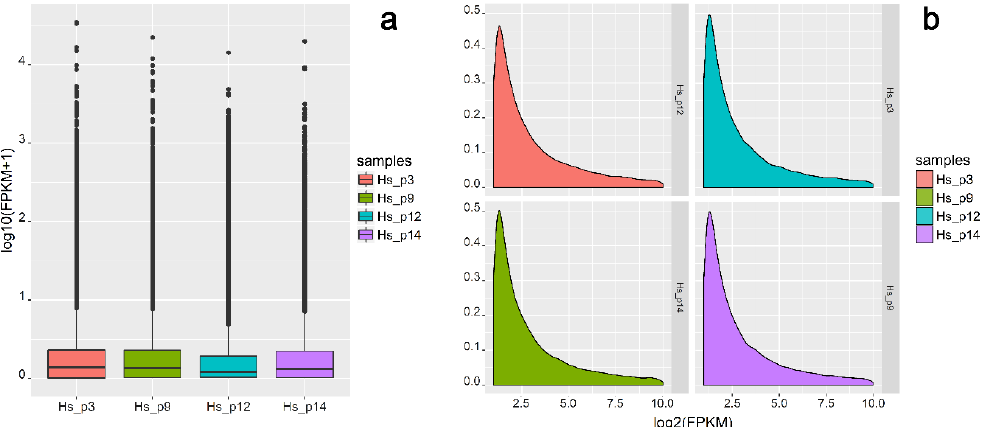
Figure 3. Transcript expression level distribution of each human term placenta sample. ( a ) Box plot of FPKM distribution with different samples on the horizontal axis and logarithmic values of FPKM on the vertical axis; ( b ) density plot of expression distribution with logarithmic values of FPKM on the horizontal axis and density on the vertical axis.